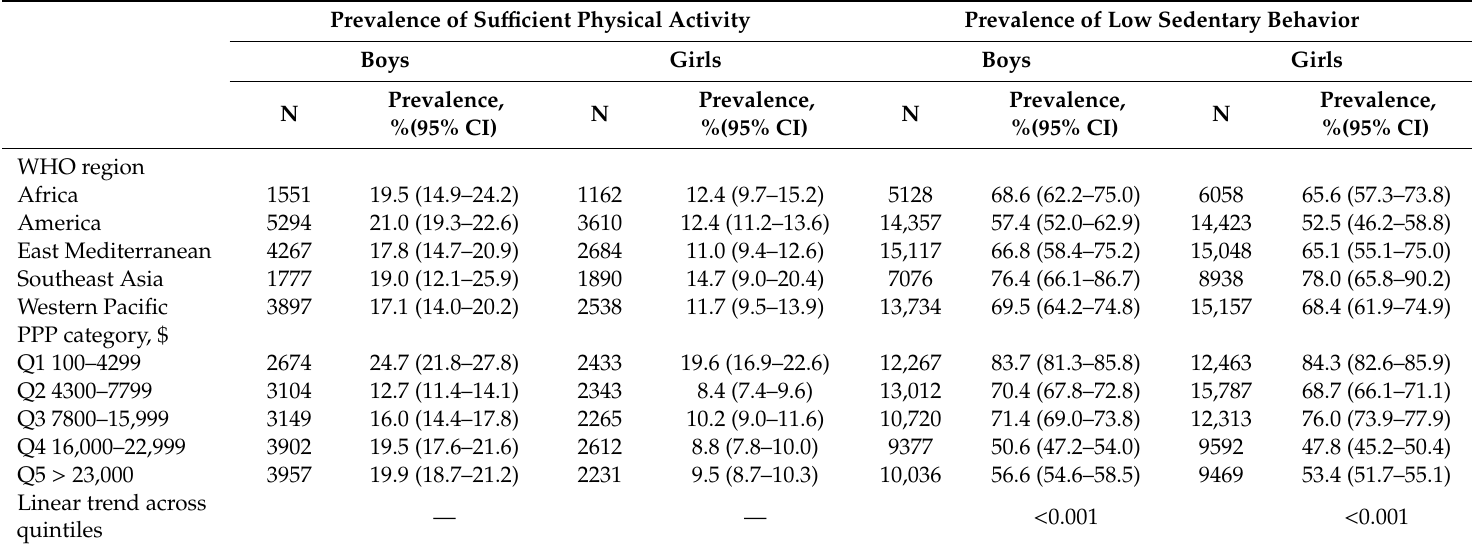
Table 3. Prevalence of su ffi cient physical activity and prevalence of low sedentary behavior in adolescents aged 12–15 years by sex, WHO region, and PPP category. Prevalence of Su ffi cient Physical Activity Prevalence of Low Sedentary